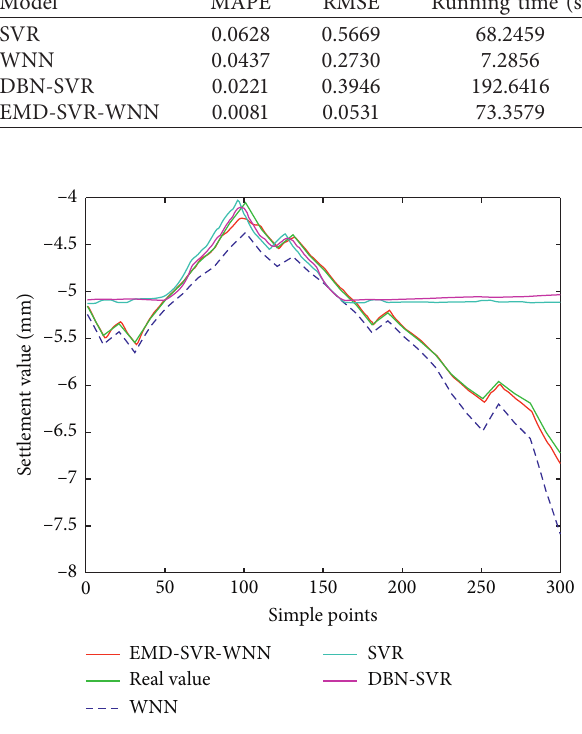
Figure 12: Comparison of different prediction